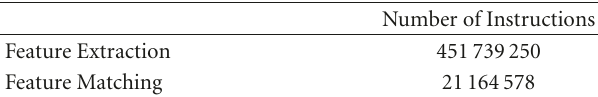
Table 1: Number of instructions required for fingerprint verifica- tion [25].